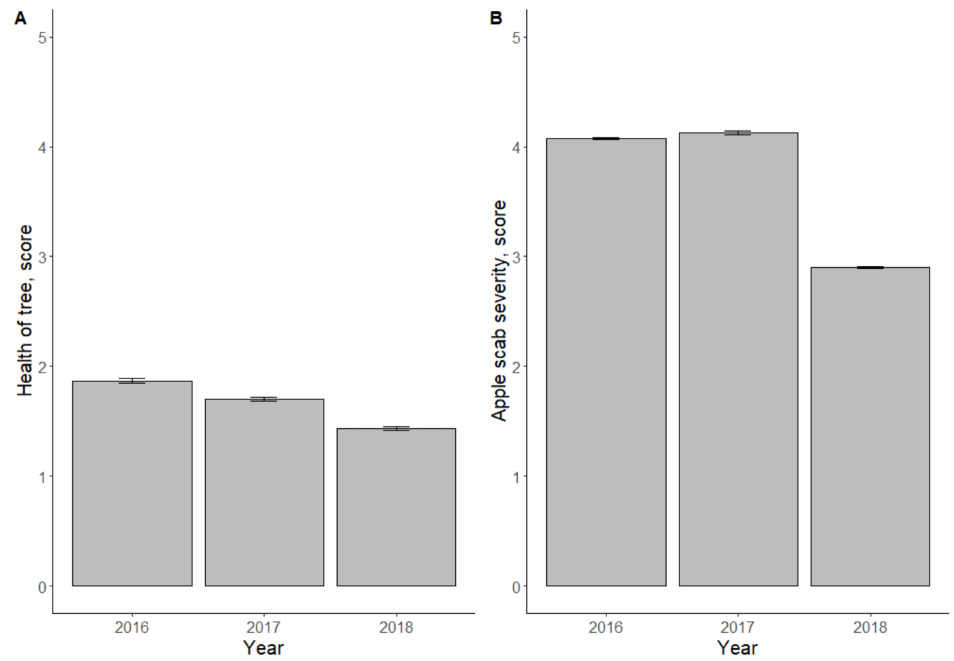
Figure 1. The comparison of mean values for health status of tree ( A ) and scab severity on leaves ( B ) among years of evaluation (2016, 2017 and